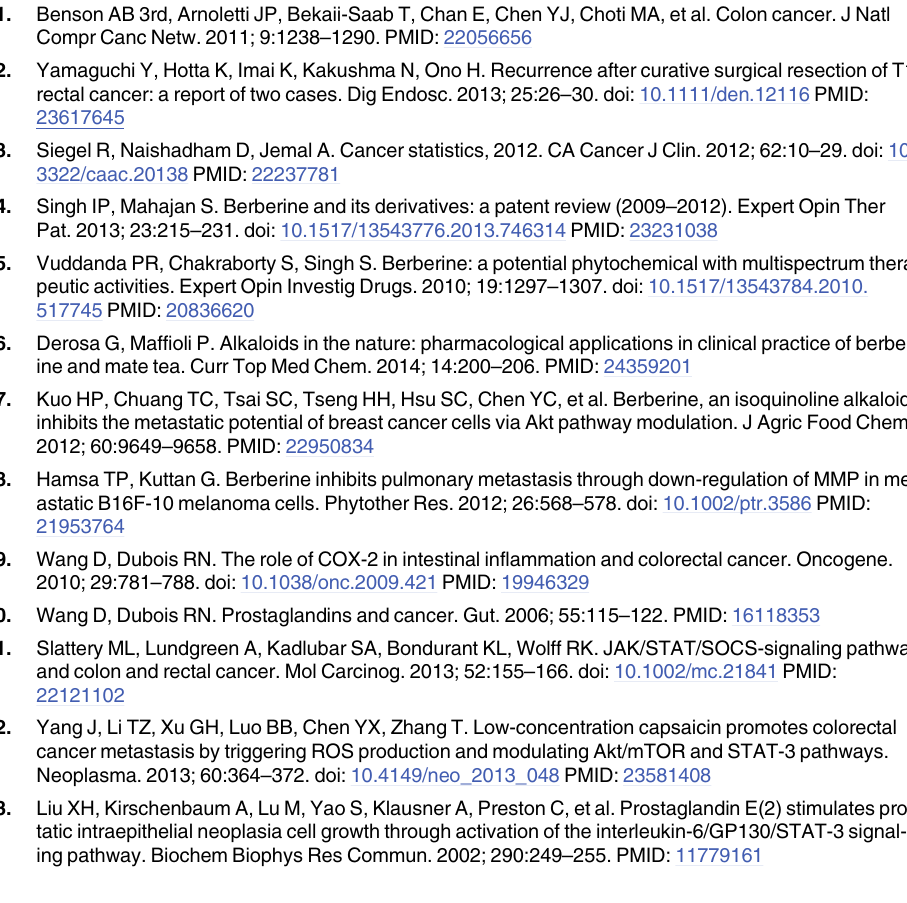
S1 Fig. Berberin inhibits CRC cell growth and metastasis. Body weight of mice, control vs berberin group. Treatment with berberin has little effect on mouse body weight. No significant difference between animals treated with berberin at dose of 200 mg/kg per day and the control animals. Data shown as means±SD. B. Representative liver samples from control and berberin mice were processed and staining by HE. The results shown are representative of three inde- pendent experiments.